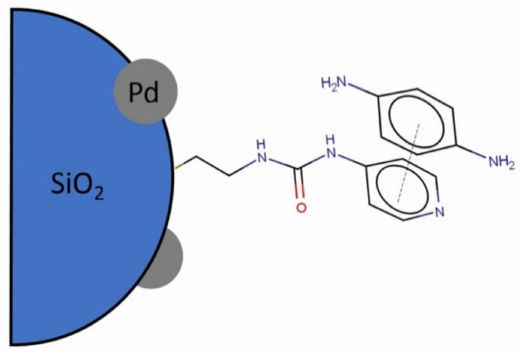
Figure 8. Schematic representation of π – π